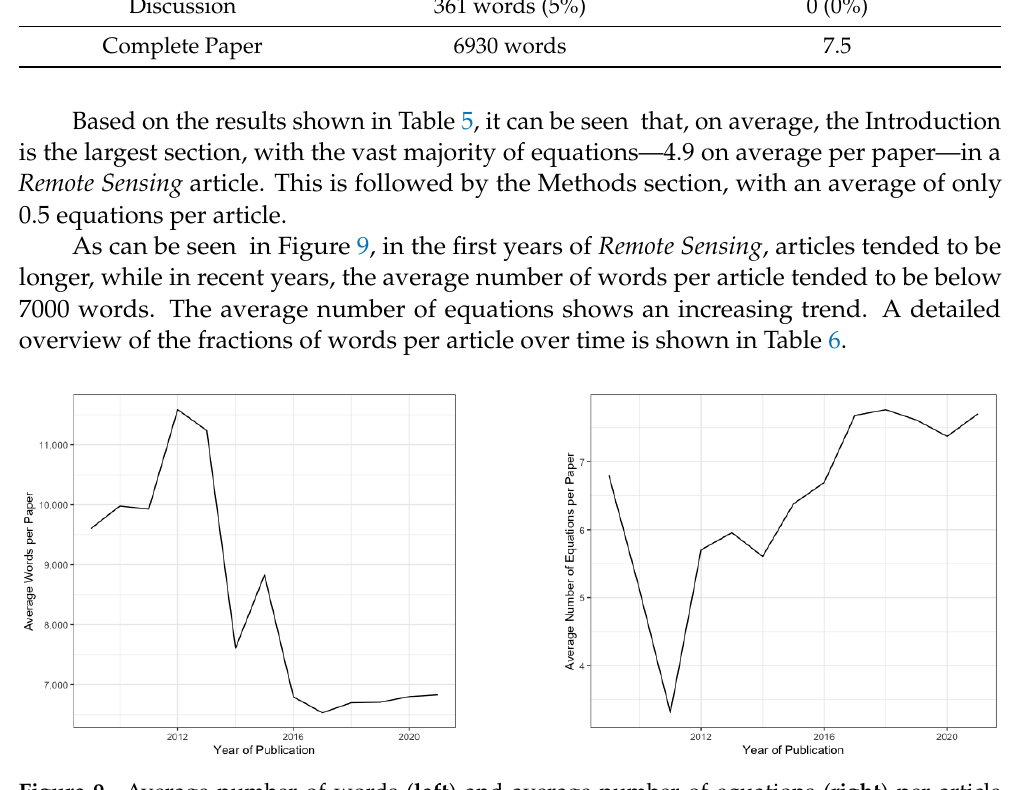
Figure 9. Average number of words ( left ) and average number of equations ( right ) per article published between 2009 and 2021 in Remote Sensing . Table 6. Average fraction of words per article section between 2014 and